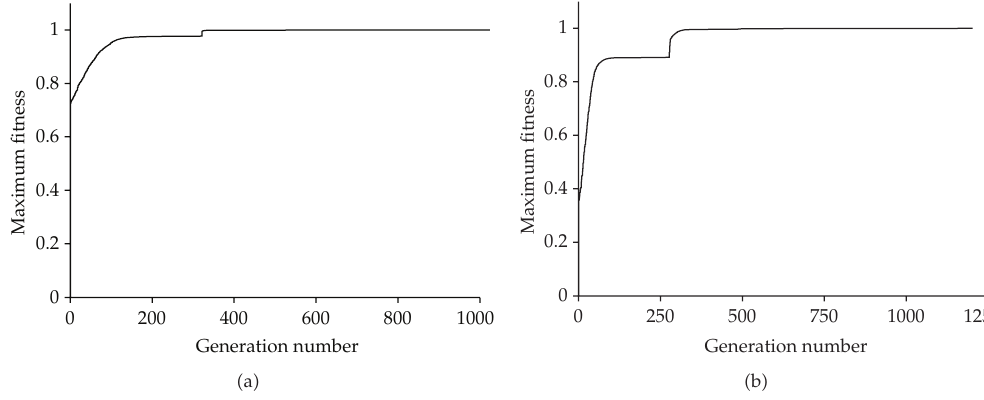
Figure 5: Evolutionary progress plots for the best-of-generation individual for (cid:3) a (cid:4) Problem 3; (cid:3) b (cid:4) Problem